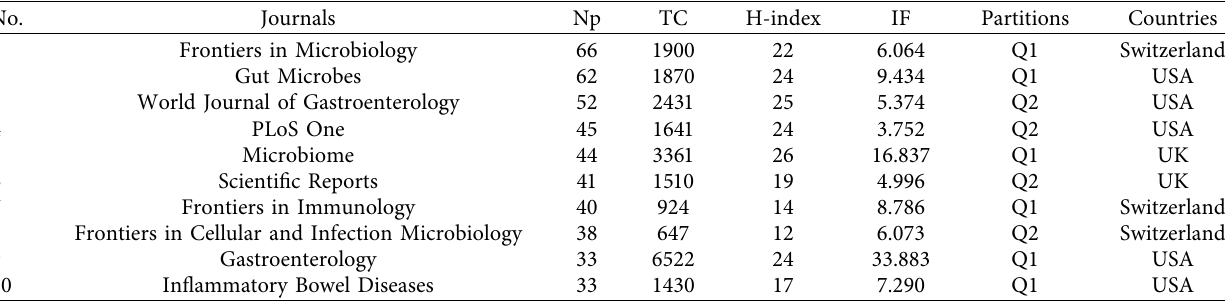
Table 1: Te top 10 high-yield journals in FMT research.